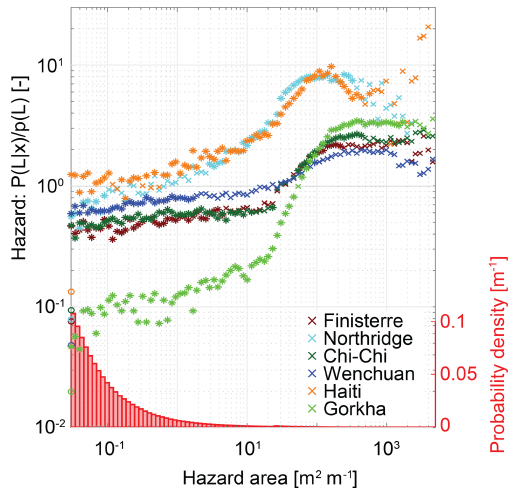
Figure 6. Landslide hazard defined as the conditional landslide probability P(L | x) normalised by study area average landslide probability P(L) for the hazard area. Hazard area is calculated with global average parameters θ m and θ s – that is, the areas with slope greater than 40 ◦ that have a flow path to the cell of interest and do not travel across a cell with a slope less than 10 ◦ . Coloured circles on the y axis indicate landslide hazard for cells with a hazard area of 0m 2 m − 1 . Asterisks indicate values for which probability dif- fers from the study area average at 90% confidence. Red bars show histograms of hazard area over the six